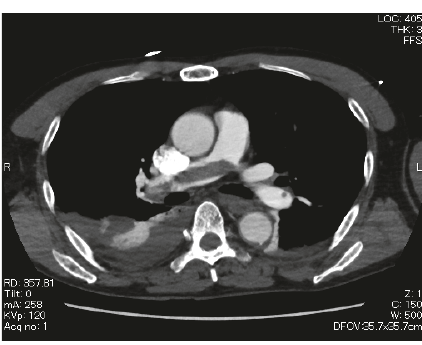
Figure 3: Enhanced computed tomography revealing a pulmonary embolism (white